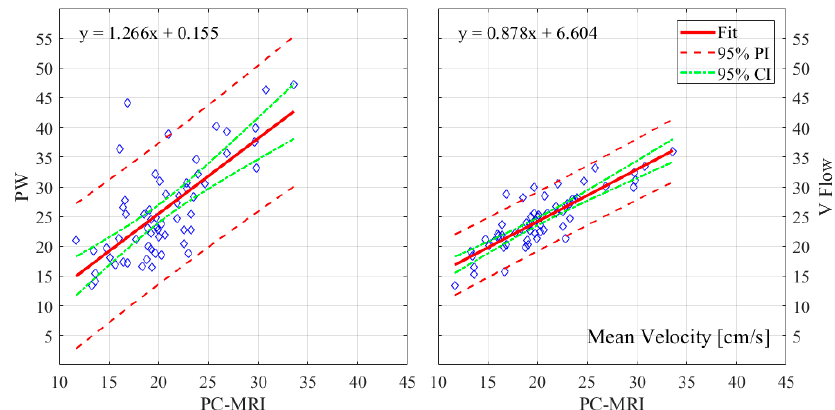
Figure 7. Linear regression plots of mean velocities with 95% PI and 95% CI for PW and V Flow relative to PC-MRI.